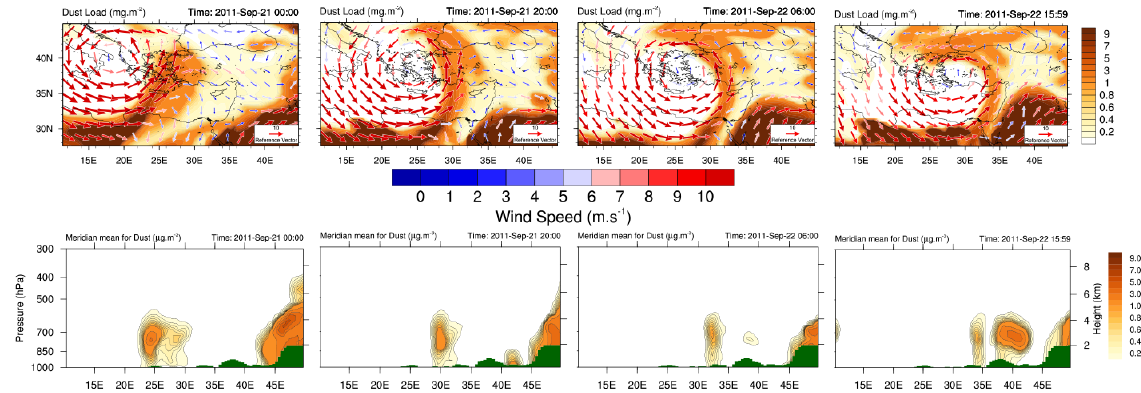
Figure 8. Time series of (top) dust load and (bottom) meridional mean for the first event at CUT-TEPAK location (34.675 ◦ N). The green shaded area represents the orography.